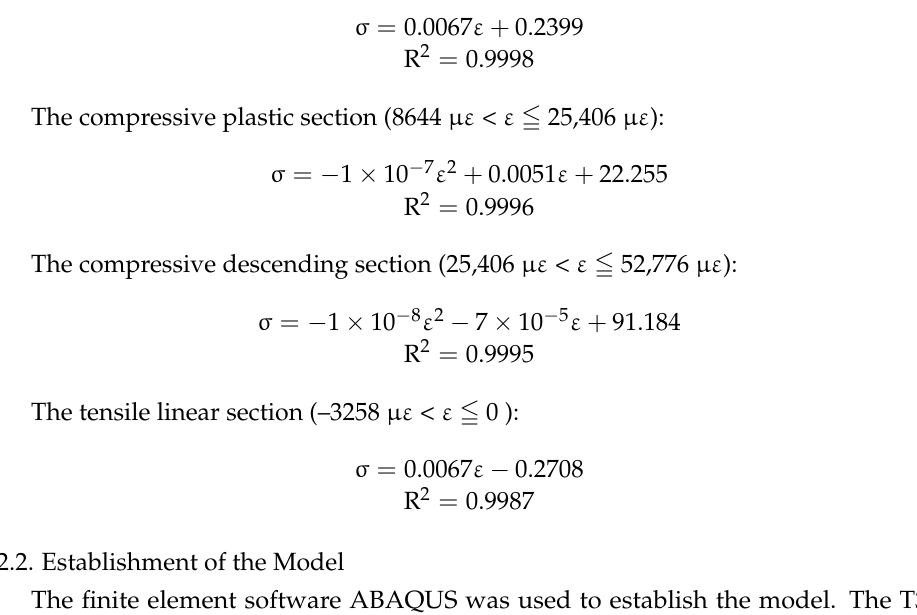
Figure 12. The uniaxial stress–strain curve of the polyurethane concrete. In the initial loading stage, the compressive stress–strain curve developed from linear to nonlinear, and the peak compressive strength and strain were 83 MPa and 25,406 με , respectively. In the later loading stage, the compressive stress–strain curve was nonlinear, and the strain at failure was 52,776 με . The tensile stress–strain curve was almost linear, and the peak tensile strength and strain were 21.9 MPa and 3258 με , respectively. The relation- ship curve was fitted, and the constitutive relationship of the polyurethane concrete can be calculated using Equations (18) to